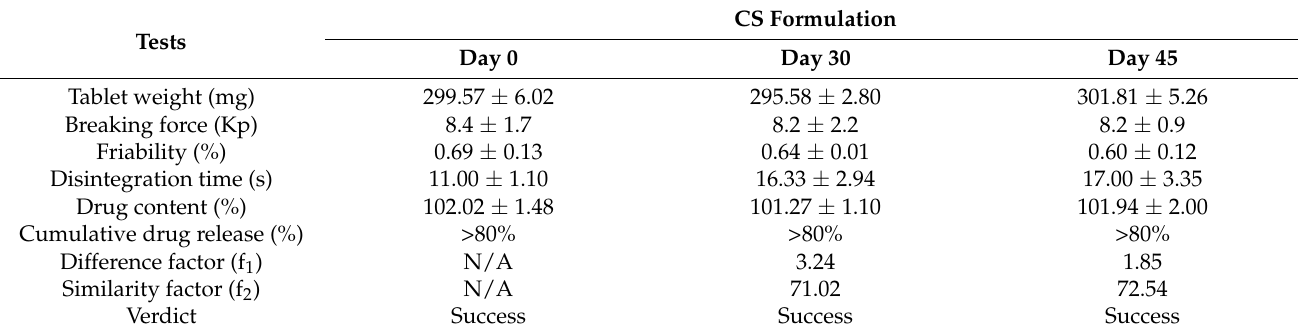
Table 8. Properties of paracetamol tablets formulated with CS at different